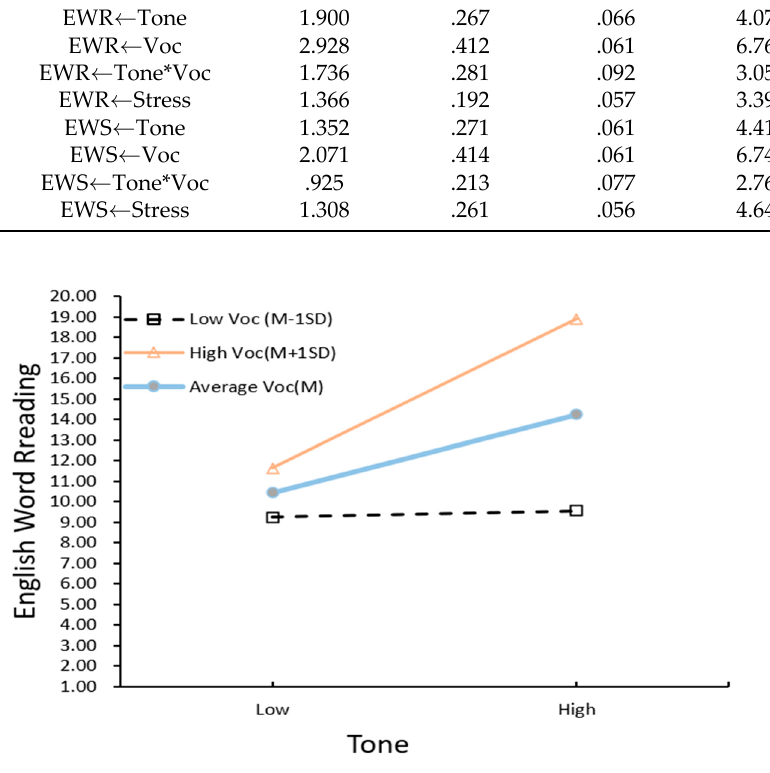
Figure 5. Performance of Grade 4 English word reading predicted by Chinese tone perception at low, average, and high levels of oral vocabulary scores. The x‑axis depicts tone and the y‑axis represents English word reading performance at low ( − 1 SD), medium (0 SD), and high (+1 SD) levels of oral vocabulary.